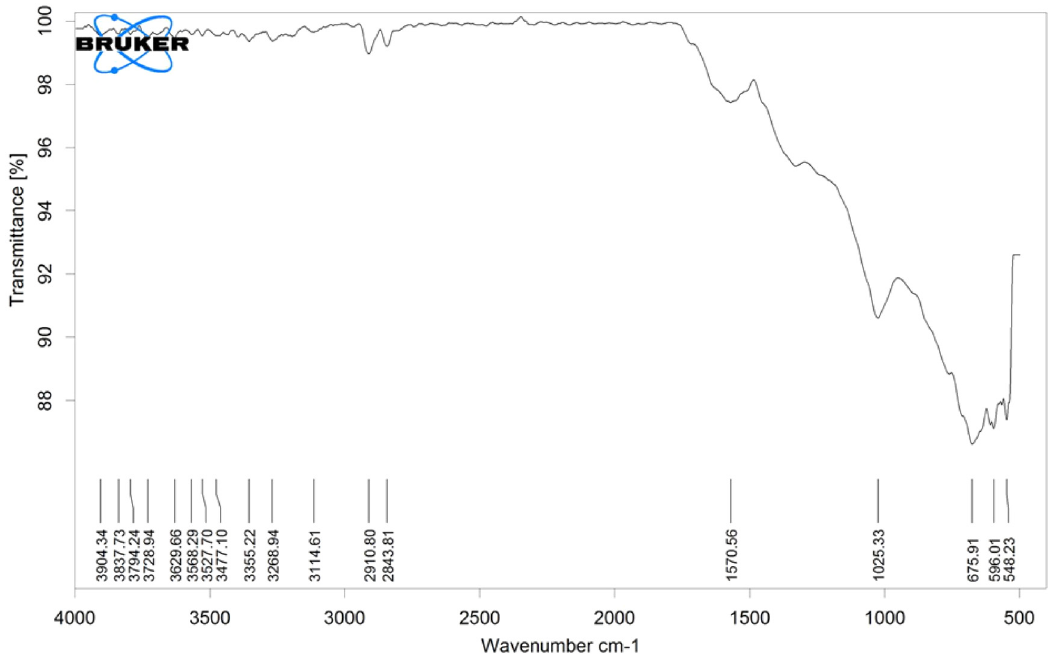
Figure 5: FTIR spectrum of synthesized Cs - AgNPs.